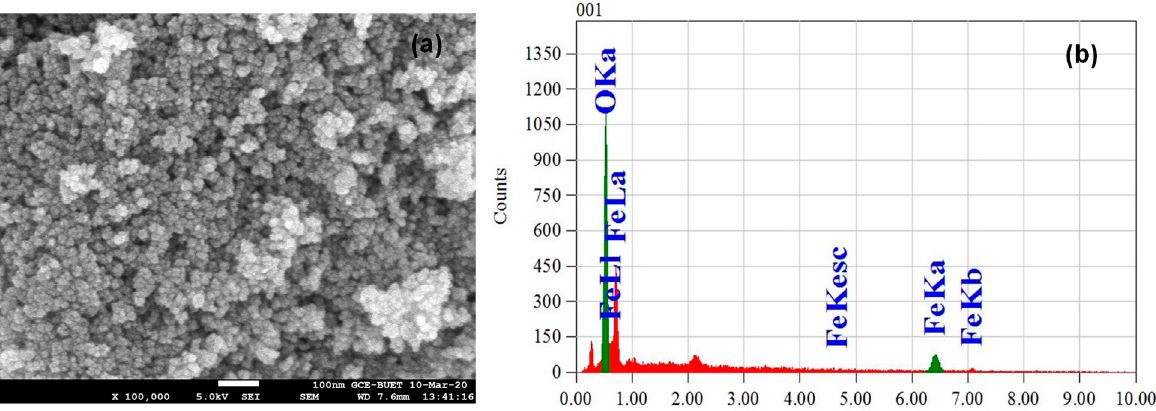
Figure 4. ( a ) SEM images of synthesized Fe 3 O 4 NPs, ( b ) EDS of Fe 3 O 4 NPs.